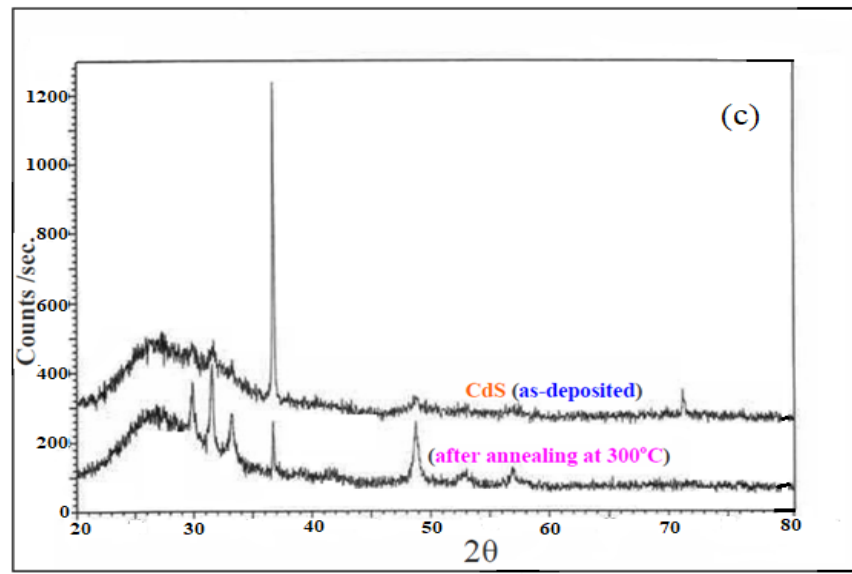
Figure 2. ( a ) Typical X-ray diffraction patterns as powder form. ( b ) In powder and thin film forms. ( c ) As-deposited and after annealing thin film at 300 °C. Table 1. X-ray data of CdS in the powder form, CdS thin film of thickness 340 nm, CdS thin film of thickness 340 nm after annealing at 300 °C. CdS in the Powder Form. CdS Thin Film of Thickness 340 nm. CdS Thin Film of Thickness 340 nm after Annealing at 300 °C.